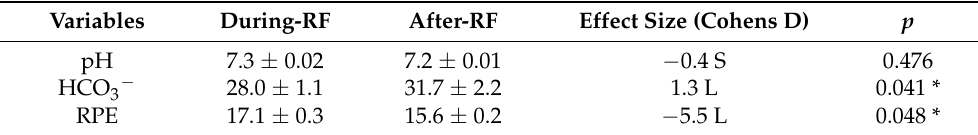
Table 2. Mean ± standard deviation values of buffering variables during (during-RF) and after Ramadan fasting